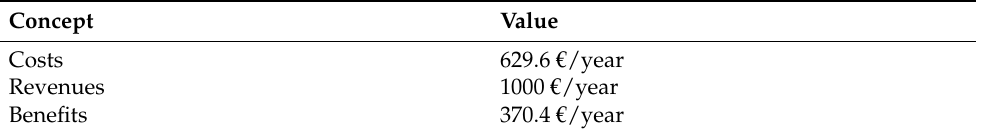
Table 9. Results of the economic analysis for the example battery